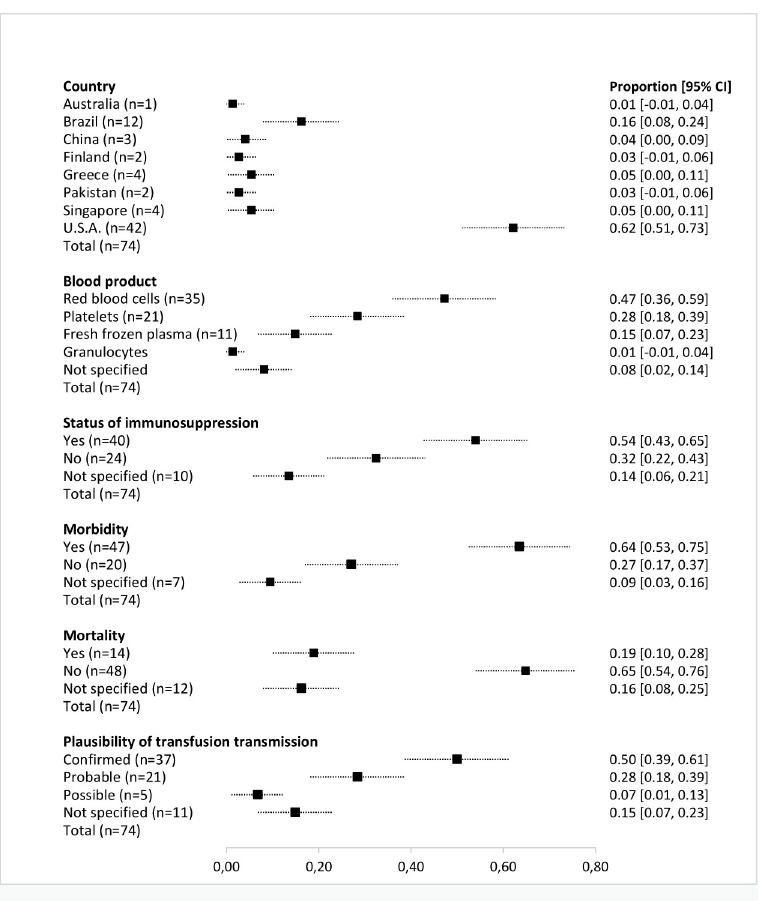
Fig 3. Main clinical and epidemiological characteristics of reported cases of transfusion-transmitted arboviruses.